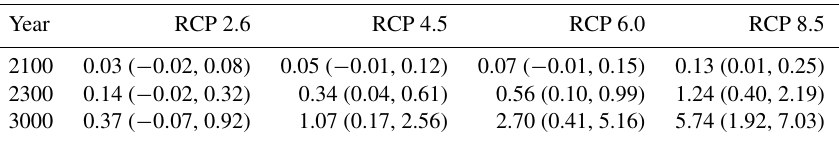
Figure 12. Same as Fig. 6 but under Weertman’s sliding law with exponent m = 5. Table 4. Same as Table 3 but with sliding exponent m = 5. (cid:49) GMSL projections are the median projections with their 5%–95% probability intervals between